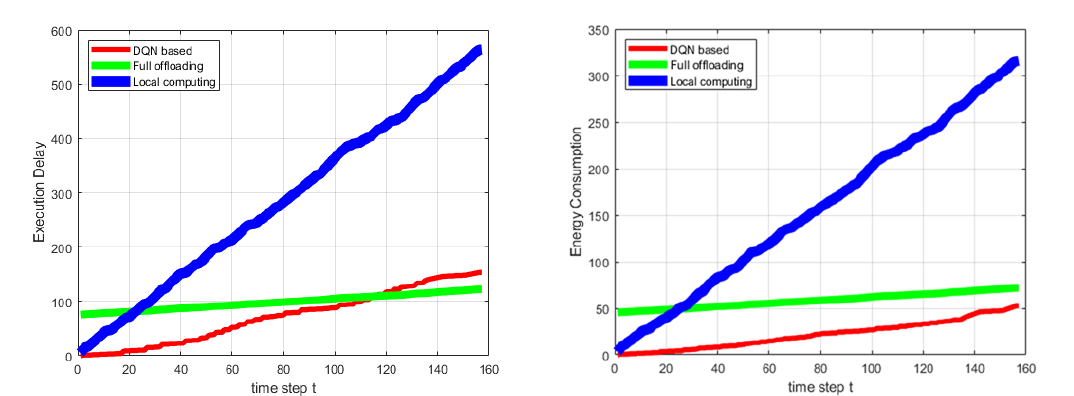
Figure 5. Accumulated reward.